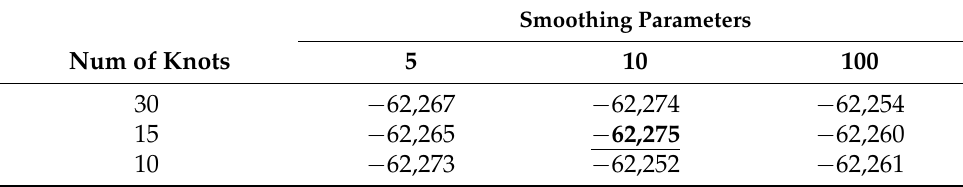
The best of each distribution is underlined, and the best overall is in bold. Table 17. Estimated parameters about limit order book (4 January 2016, AGH, Tokyo, Japan). Parameters